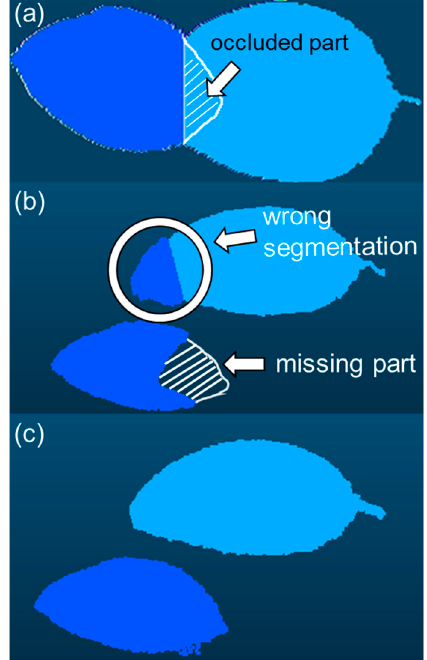
Figure 5. Example of segmentation for overlapped leaves: image ( a ) is a 2D image after initial segmentation, and image ( b , c ) show the images after segmentation via the simple-projection and attribute-expansion methods, respectively.